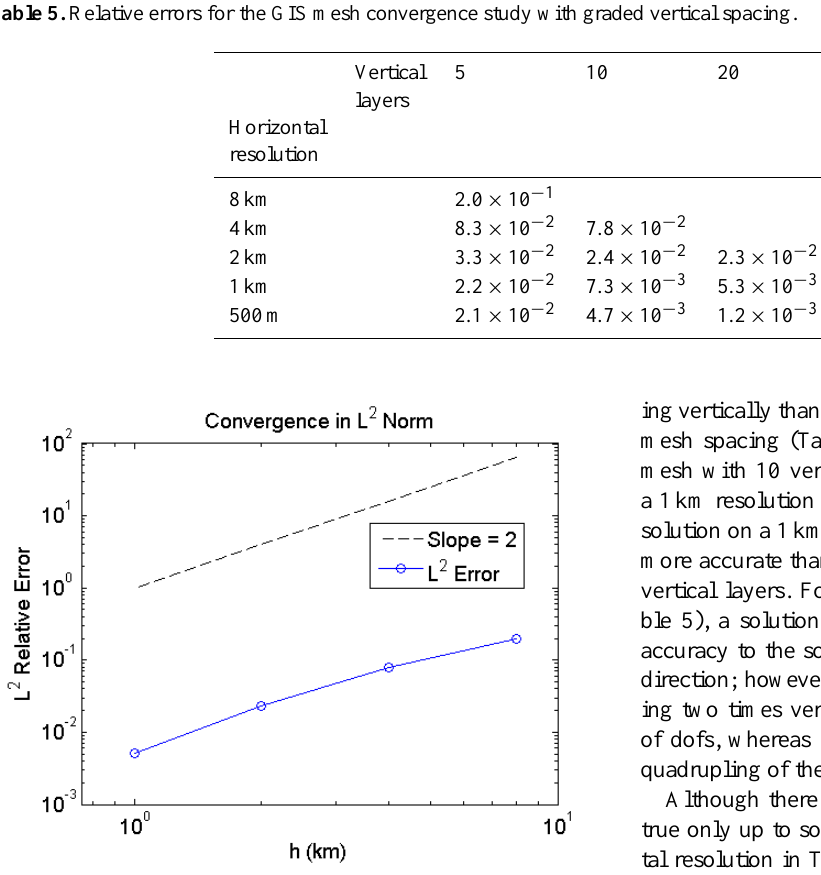
Figure 11. Convergence in the continuous L 2 norm Eq. (46) for the realistic GIS problem with full 3-D